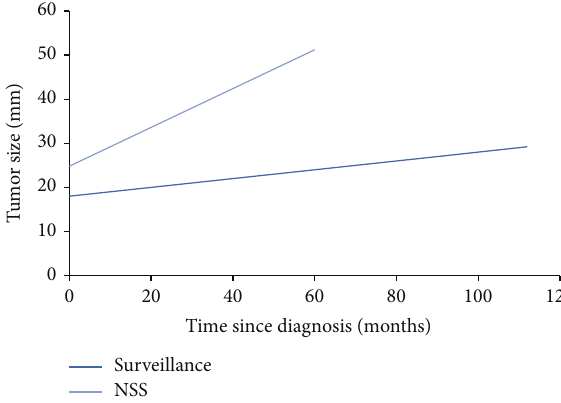
Figure 1: Growth rate of small renal masses. Growth rate of masses that underwent active treatment was 0.53 cm/year (light line) which was significantly higher than that observed for masses which were managed expectantly, 0.12 cm/year (dark line). 𝑃 < 0.0001 .